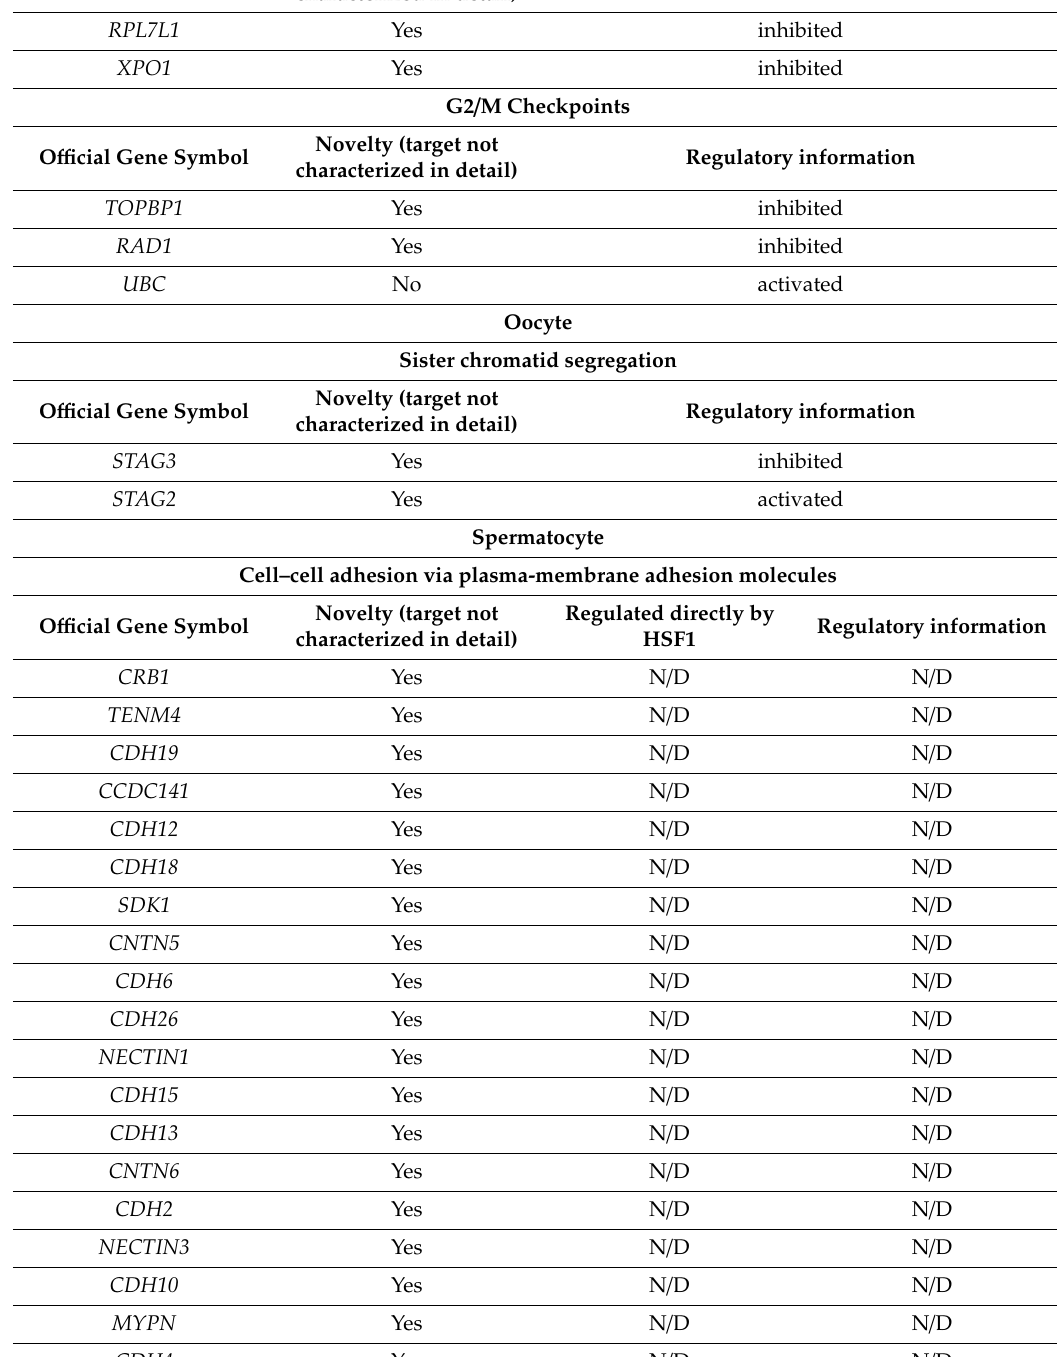
A table summarizing the HSF1 target genes identified, using the database HSF1base. Selected HSF1 target genes are ordered by functional categories, based on PANTHER analyses. A target gene is considered novel if it had not previously been characterized as a HSF1 target in a single-gene-analysis study. Regulatory information is ‘activated’ or ‘inhibited’ if there is evidence for HSF1 dependent up- or down-regulation of the expression of the given gene. ‘N / D’ means there is no regulatory information